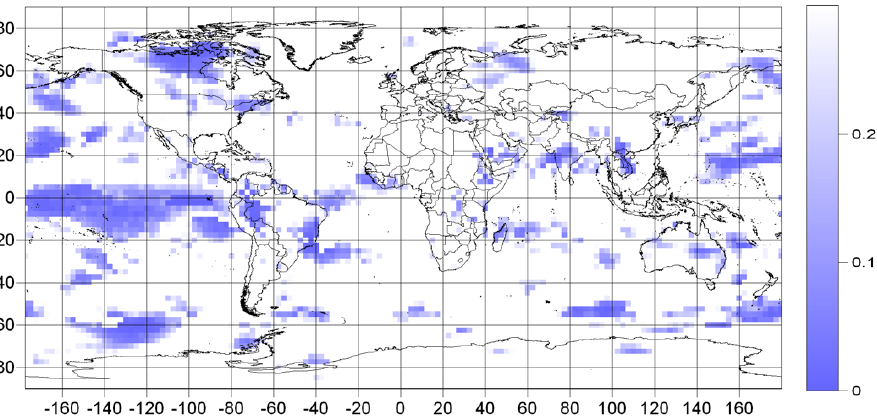
Fig. 2. The probability values associated with the cycle of 43months (see Sect. 2.2). The cycles observed in a zone corresponding to the colour white are not